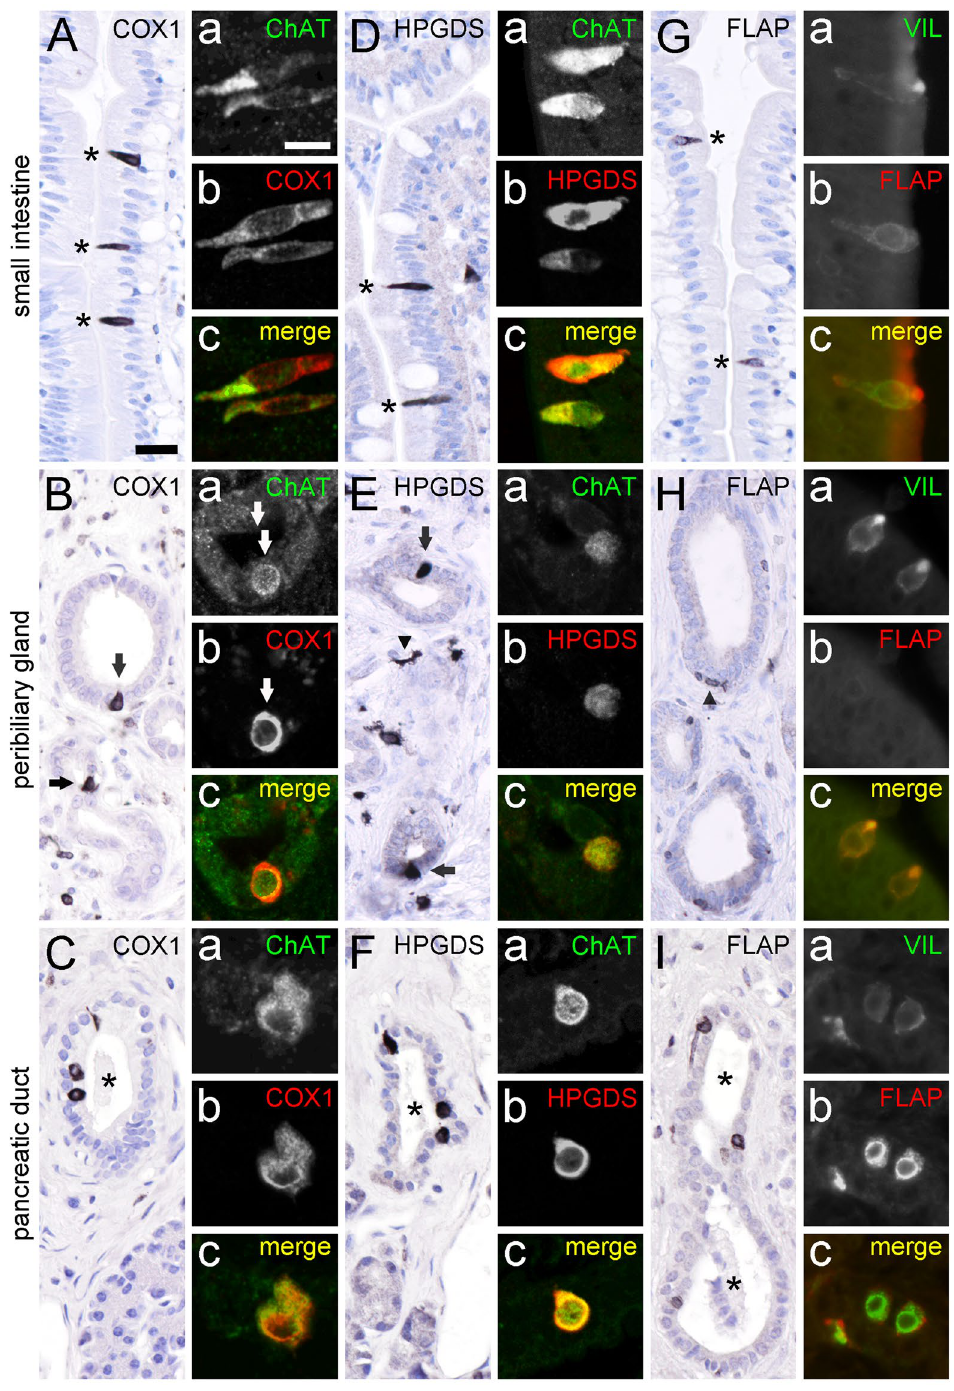
Figure 4. ChAT-immunoreactive tuft cells express proteins for prostaglandin and leukotriene production. COX1-ir is present in solitary cells in the human small intestine mucosal epithelium ( A , marked with asterisks), in accessory bile ducts ( B , marked with arrows), and in pancreatic ducts ( C , duct marked by asterisk). Double-immunofluorescence analysis revealed complete co-expression of ChAT (rabbit-anti-ChAT antiserum) with COX1 in epithelial cells ( A a–c, B a–c, and C a–c). HPGDS-ir is present in solitary cells in the human small intestine mucosal epithelium ( D ; marked with asterisks), in peribiliary glands ( E , marked with arrows), and in pancreatic ducts ( F , duct marked by asterisk). HPGDS-ir cells in the stroma most likely represent tissue macrophages (arrowhead in E ). Again, double-immunofluorescence analysis of ChAT (goat- anti-ChAT antiserum) with HPGDS revealed co-expression in these cells ( D a–c, E a–c, and F a–c). FLAP-ir is present in solitary cells in the human small intestine mucosal epithelium ( G , marked with asterisks), and in pancreatic ducts ( I , duct marked by asterisks). FLAP-ir is not present in the peribiliary gland epithelium ( H ). Here, presumably epithelium-associated macrophages stain positive for FLAP (arrowhead in H ). Double- immunofluorescence analysis of villin with FLAP revealed co-expression in small intestine ( G a–c), and (2019) 9:17466 | https://doi.org/10.1038/s41598-019-53997-3